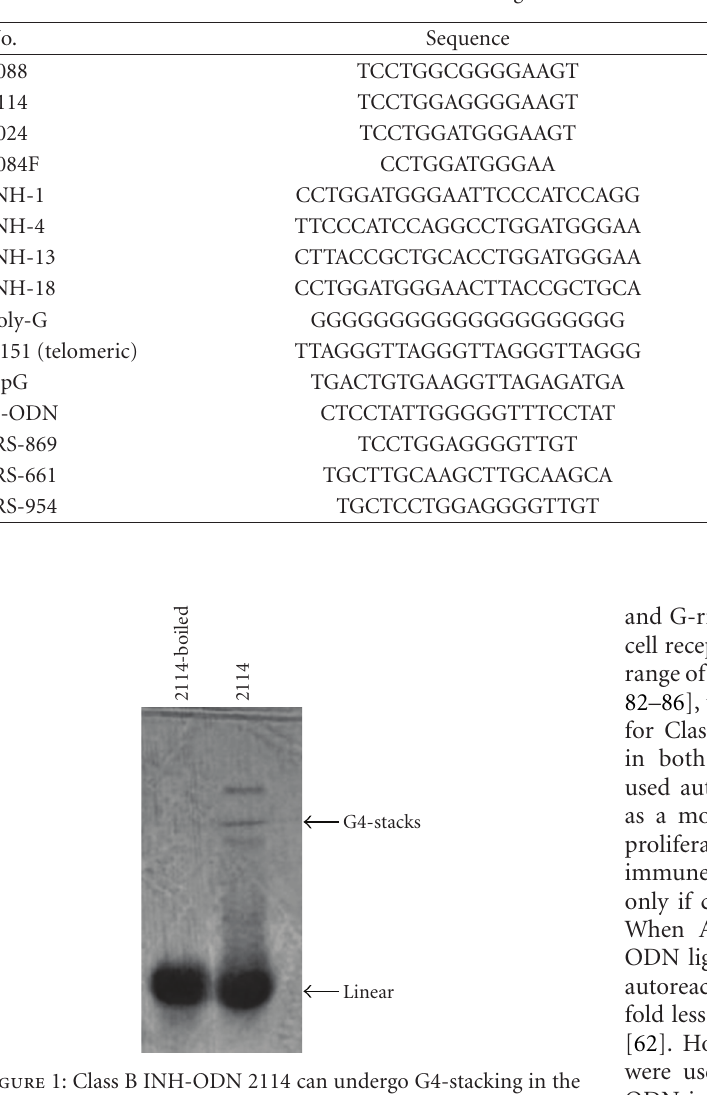
Table 1: Oligonucleotides used in this study.